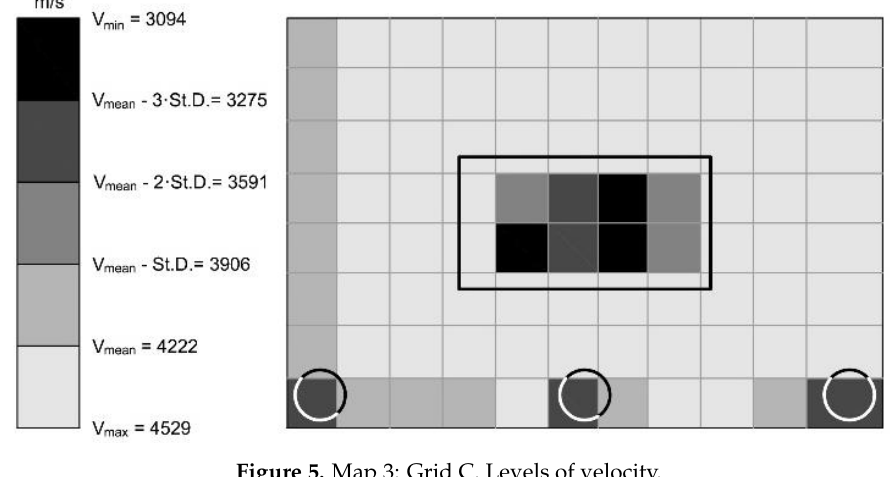
Figure 5. Map 3: Grid C. Levels of velocity.